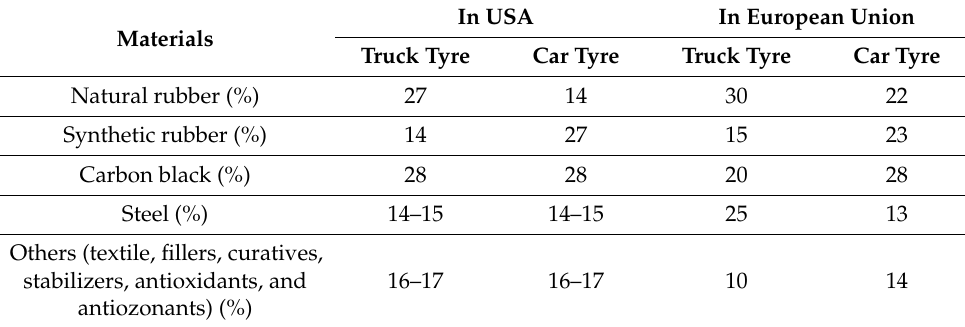
Figure 1. Various sizes of tire particles [48]. Table 3. Composition of manufactured tires by weight [23,24,42].